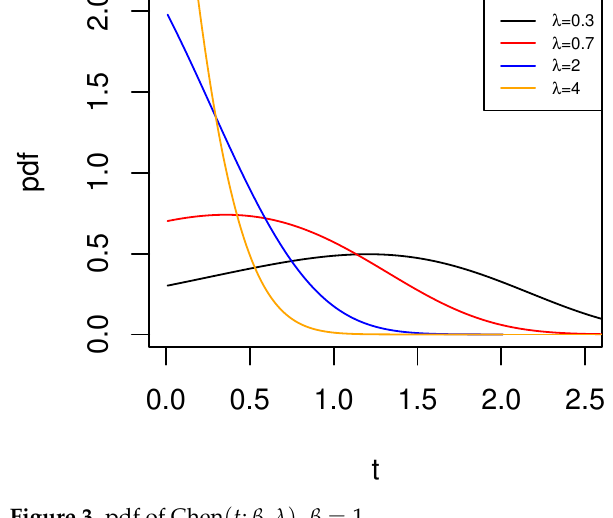
Figure 3. pdf of Chen ( t ; β , λ ) , β = 1.